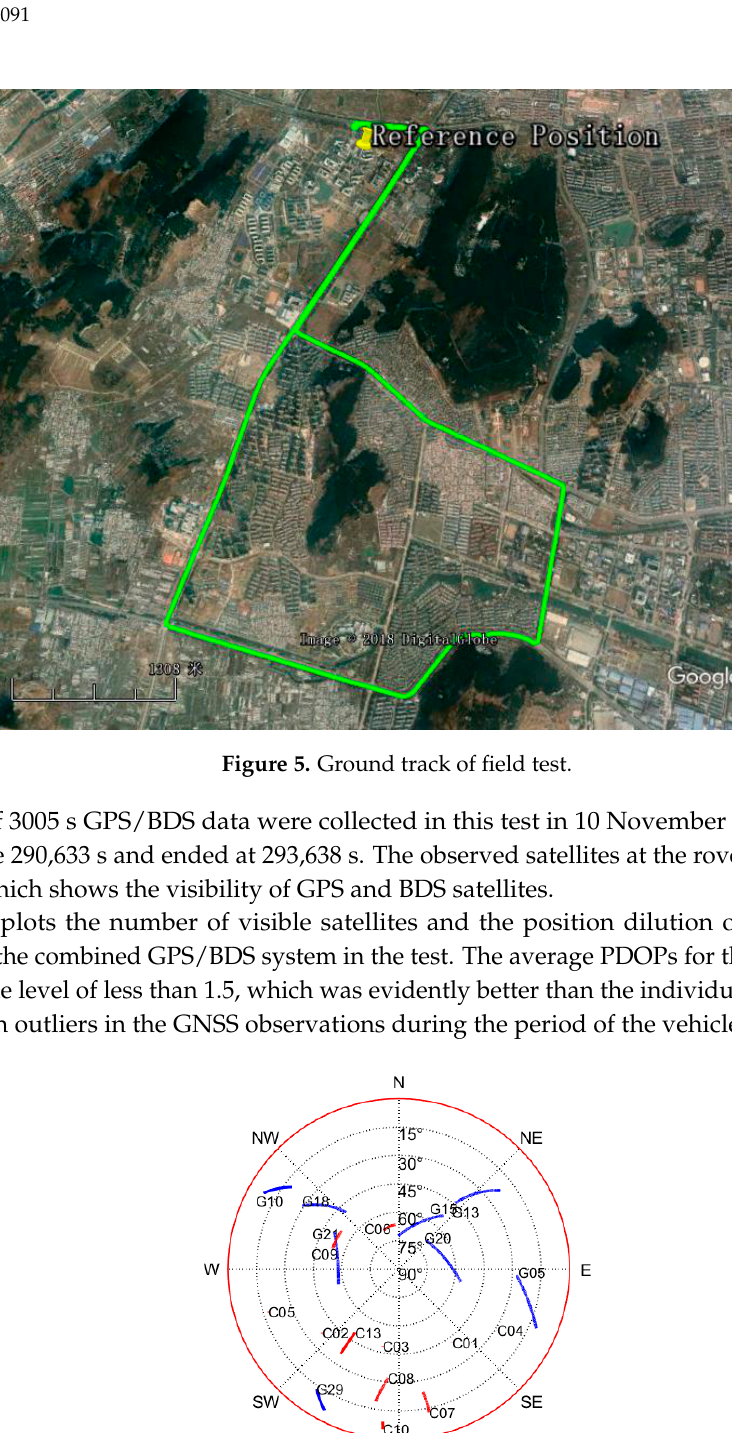
Figure 7. Satellites visibility in the test. A loosely ‐ coupled strategy is adopted to calculate the navigation solutions of the GPS/BDS/INS integrated system based on conventional EKF. Figure 8 illustrates the estimation of the accelerometer bias and the gyro bias for IMU sensors in integrated system, as expected, the sensor bias quickly converges to a stable value after the initial disturbances and the estimated sensor bias is consistent with the sensor specifications provided by the manufacturer. ( a ) ( b ) Figure 8. Accelerometer bias ( a ) and gyro bias ( b ) for IMU sensors. 4.2. Optimal RBF Neural Network Training If GPS/BDS signals are available, the standard EKF strategy is adopted to calculate the navigation solutions of the GPS/BDS/INS integrated system. Simultaneously, the specific increments 291000 291500 292000 292500 293000 293500 294000 GPS time(s) -0.3-0.2-0.100.10.20.30.4 G y r o b i as ( d e g / s ) X Y Z